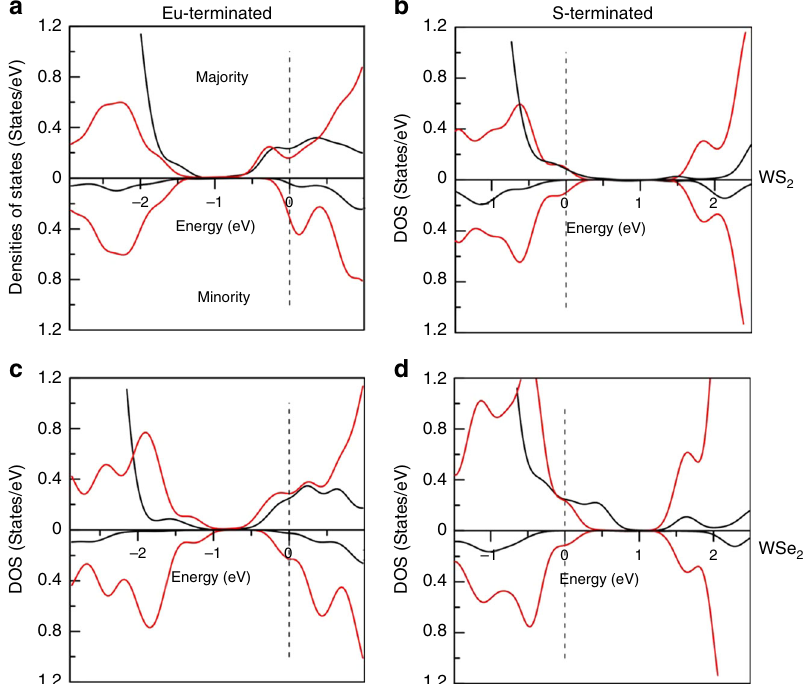
Fig. 6 Density of states. Partial densities of states of surface Eu (black) and W (red) of WS 2 /EuS and WSe 2 /EuS for polar surface of EuS: a WS 2 /EuS terminated by Eu atoms; b WS 2 /EuS terminated by S atoms; c WSe 2 /EuS terminated by Eu atoms; and d WSe 2 /EuS terminated by S atoms. (Upper half of the plots-majority, lower half of the plots-minority). Fermi energy is placed at zero and marked by dashed vertical